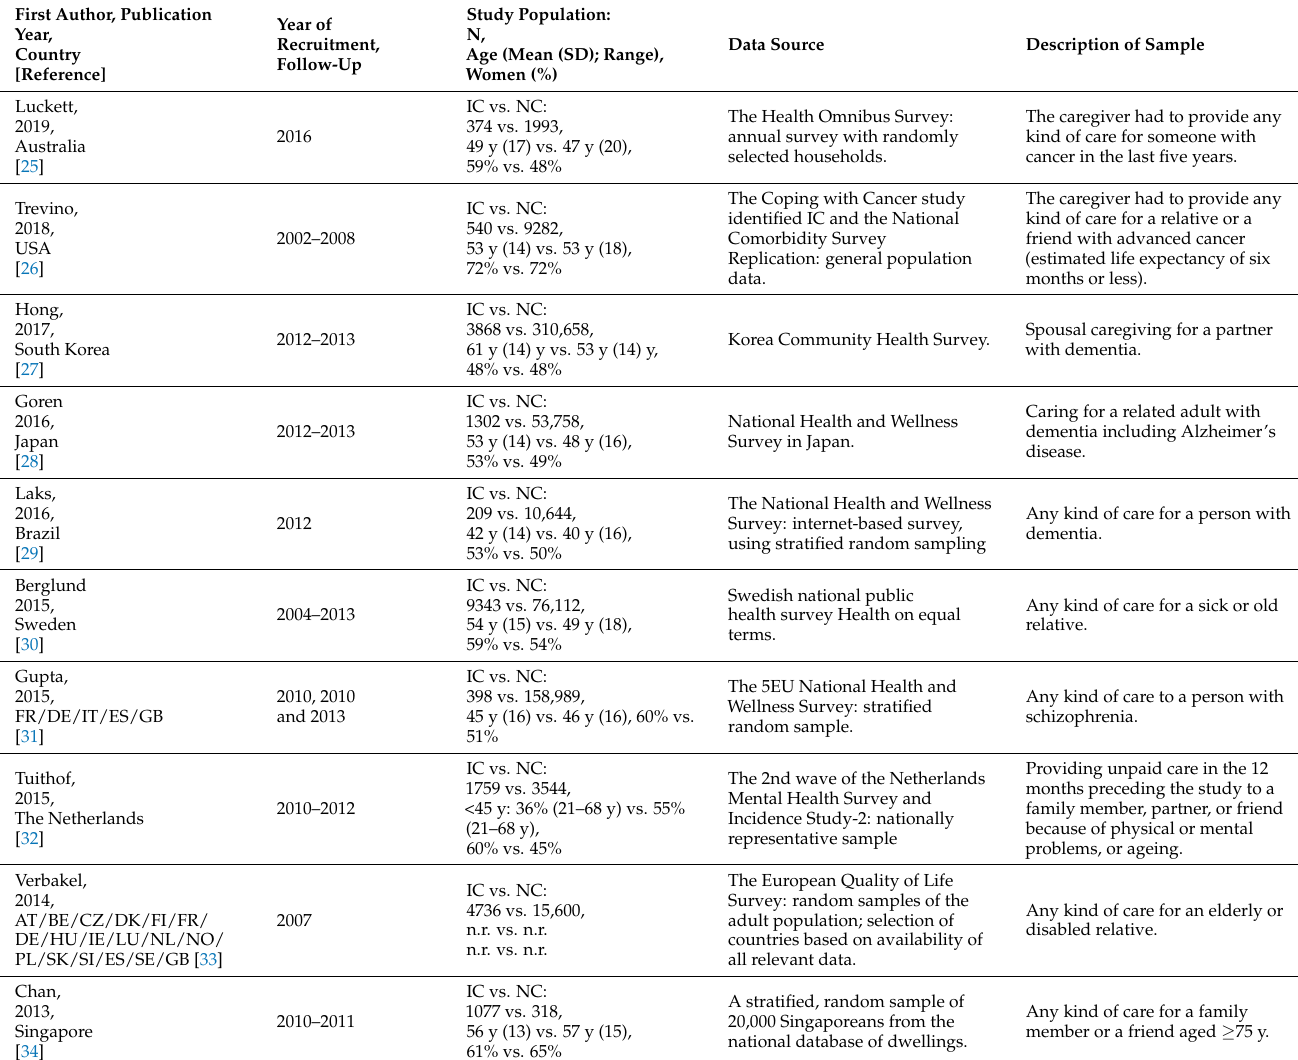
Table 2. Basic characteristics of cross-sectional studies comparing occurrence of